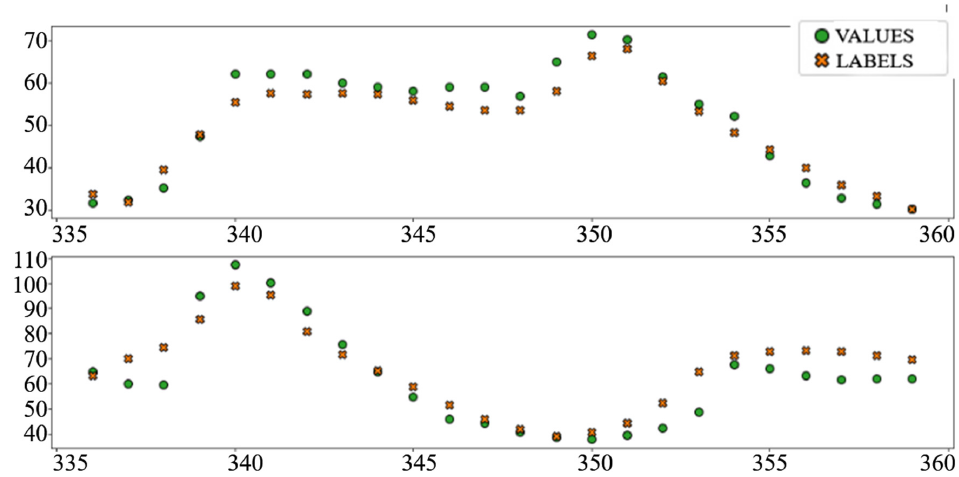
Figure 15. Price prediction examples: “AR